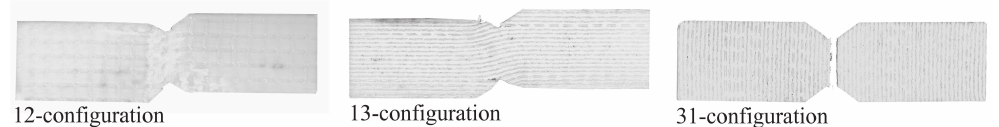
Figure 4. Post-experimental images of representative deformation and failure patterns for the investigated material